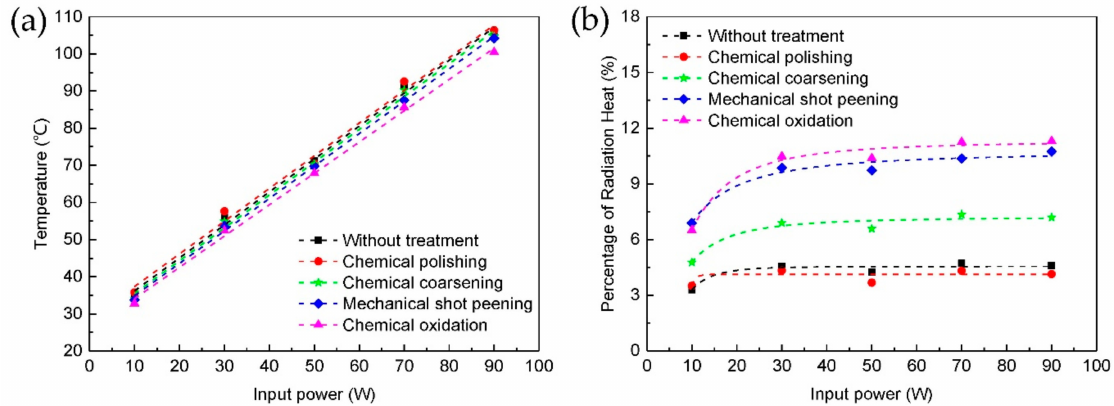
Figure 6. Performance of heat sinks with different surface treatment in wind tunnel under different heating power: ( a ) temperature of heat sinks, ( b ) percentage of radiation